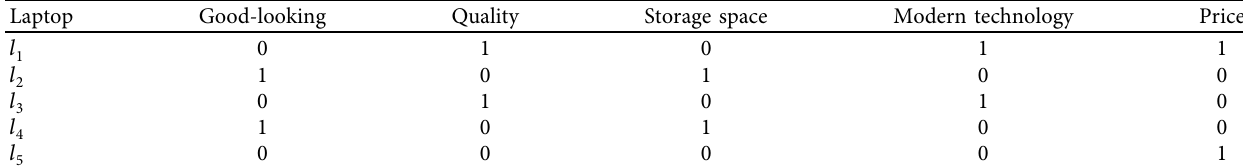
Table 1: How the person chooses the